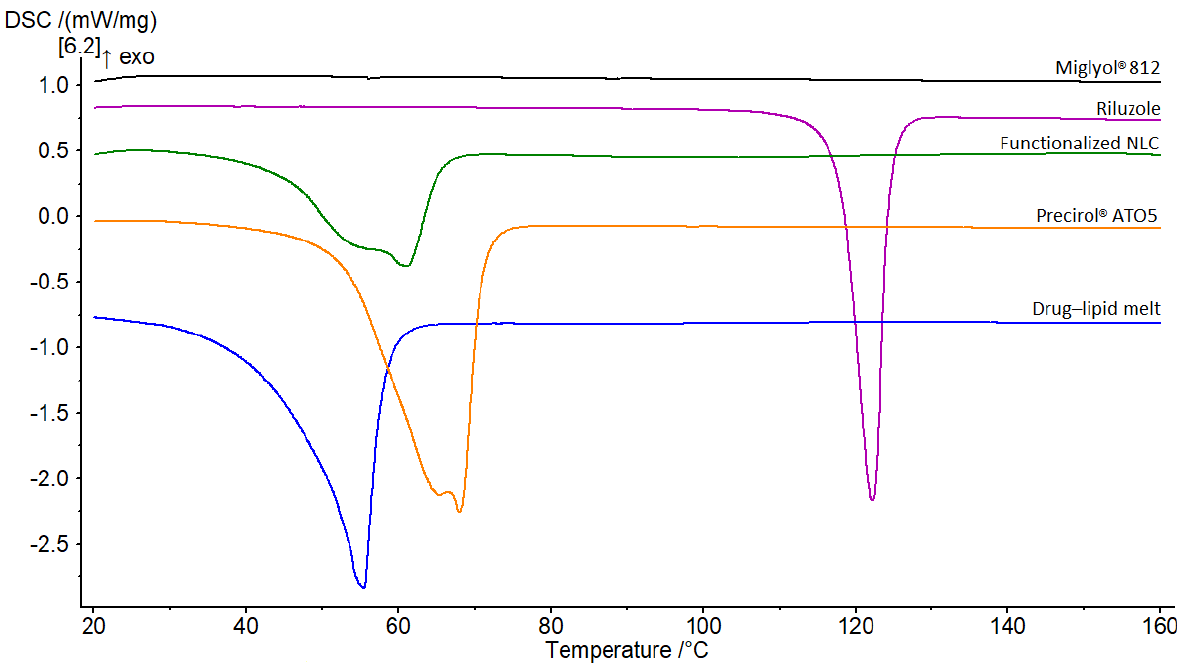
Figure 5. DSC thermograms of Miglyol ® 812, riluzole, functionalized NLC, Precirol ® ATO5 and, drug–lipid melt.